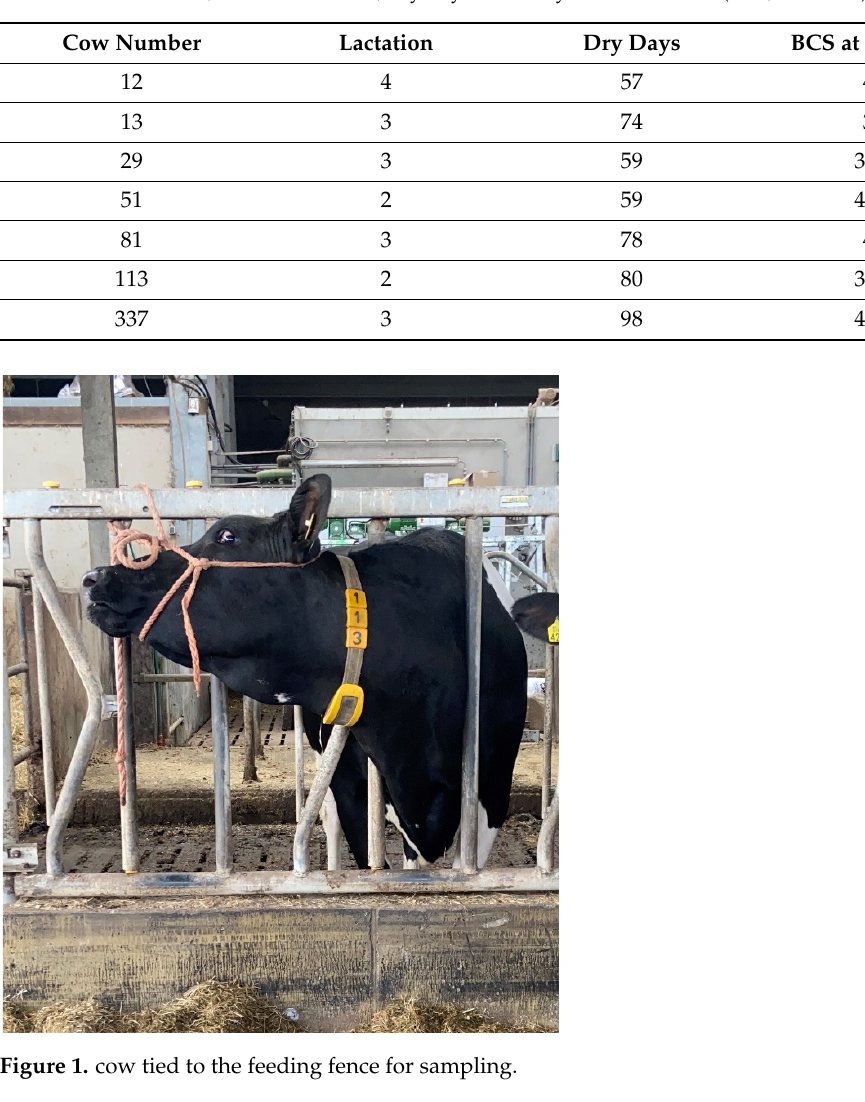
Table 1. Cow number, lactation number, dry days and body condition score (BCS, scale 1–5) at calving.